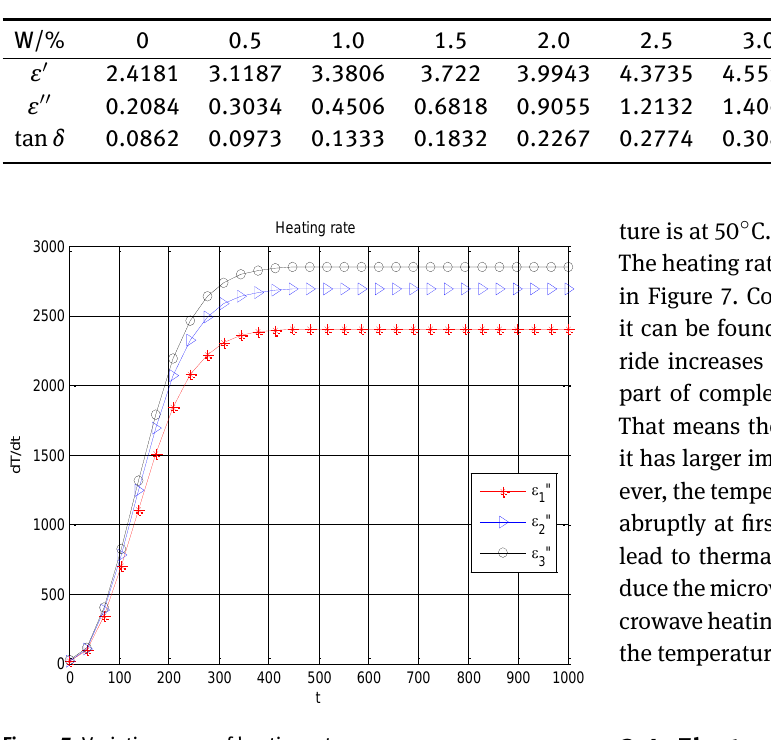
Figure 7: Variation curve of heating rate